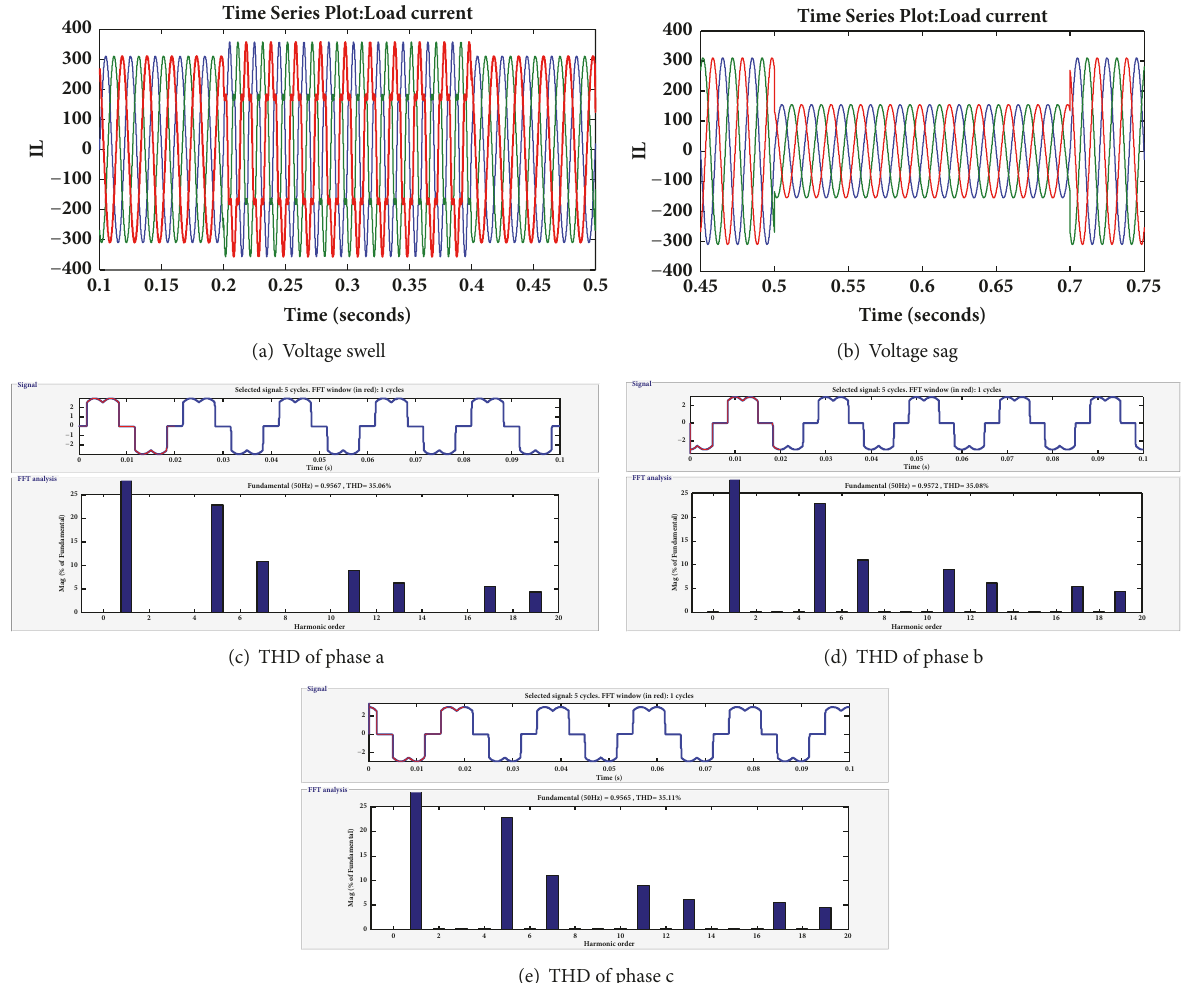
Figure 6: Load voltage and THD during distortions and without connecting